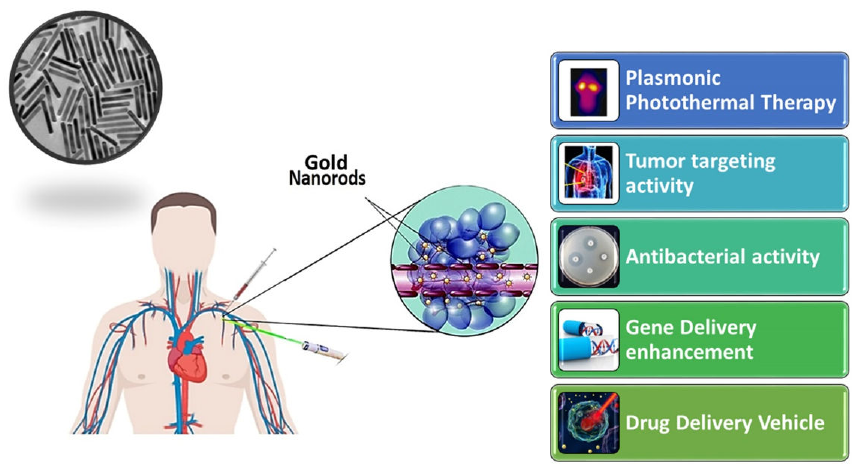
Figure 2. Schematic Illustrations of Nanorod application.